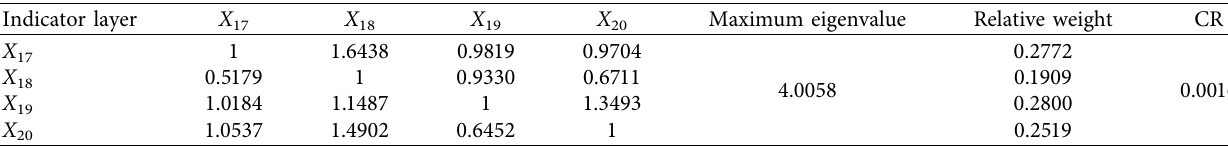
Table 14: Judgment matrix and weights of indicator layer indices in criterion B